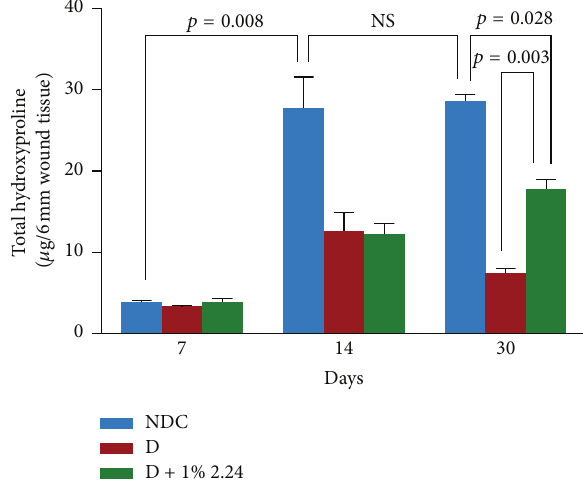
Figure 9: The effect of diabetes and CMC2.24 on hydroxyproline levels in skin wounds at 7, 14, and 30 days. Each value represents the mean ± SEM (3 rats/group) for 7 days and for 14 days and 30 days (4